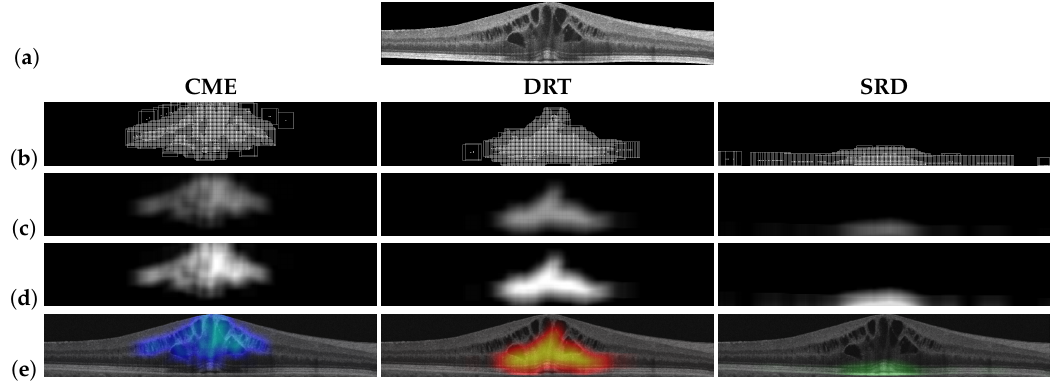
Figure 7. Representation of the different steps followed to generate the confidence maps. ( a ) extracted ROI, ( b ) image sampling, ( c ) voting, ( d ) normalization and ( e ) color